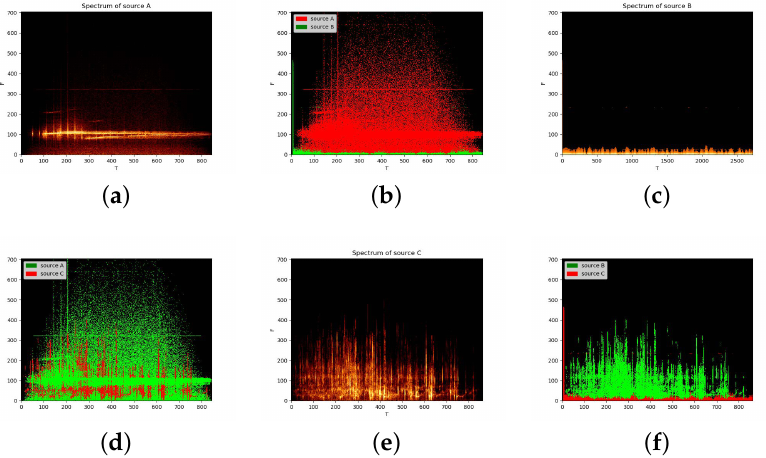
Figure 9. Visualization of separation of two-source mixtures. ( a , c , e ) show the spectrum of sources A, B and C separately and ( b , d , f ) show the separation results of the pairwise mixtures of A, B and C,